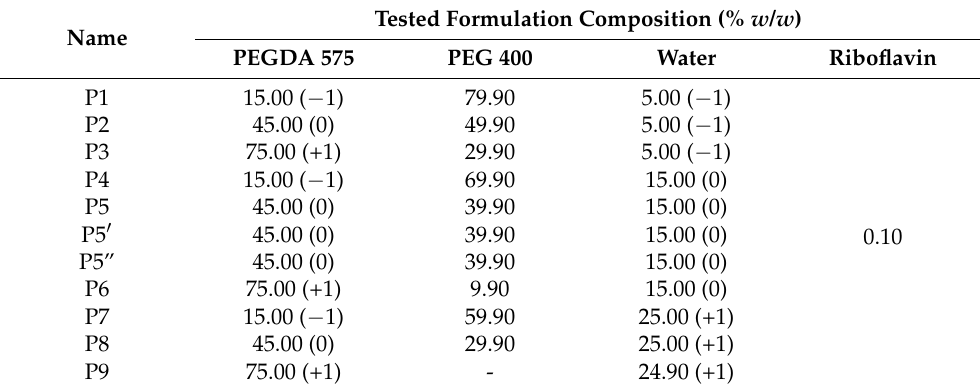
Table 1. The composition (% w / w ) of the placebo resins based on the full factorial design of the experiment. Encoded levels of factors are presented in